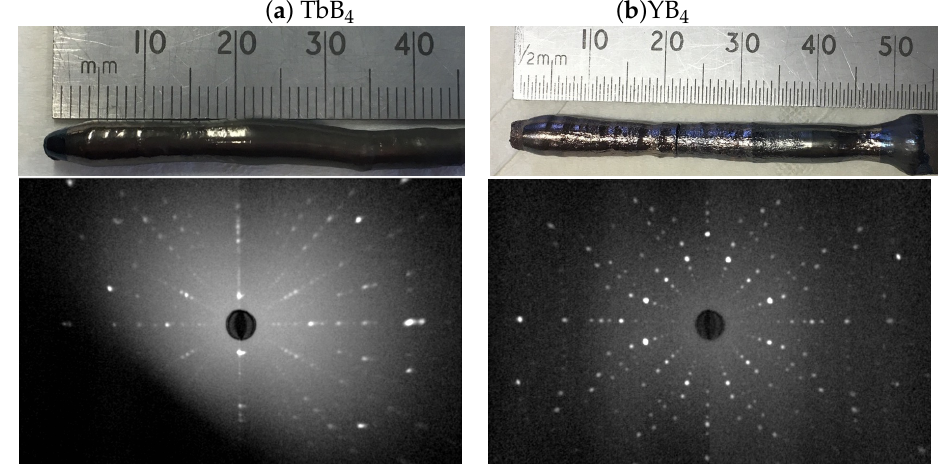
Figure 12. ( a ) Boule of TbB 4 prepared by the floating-zone method in an argon atmosphere at a growth rate of 15 mm/h, and X-ray Laue back reflection photograph, showing the [110] orientation. ( b ) Boule of YB 4 prepared by the floating-zone method in an argon atmosphere at a growth rate of 20 mm/h, and X-ray Laue back reflection photograph, showing the [001] orientation.